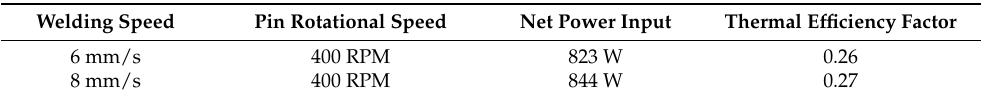
Figure 8. Comparison between predicted and measured thermal cycles for the butt weld produced at a welding speed of 8 mm/s. The indicated thermocouple locations are defined in Figure 6. Table 3. Predicted values for the net power input during butt welding 4 mm thick plates of AA6082-T6 at two different welding speeds using the HYB PinPoint extruder.